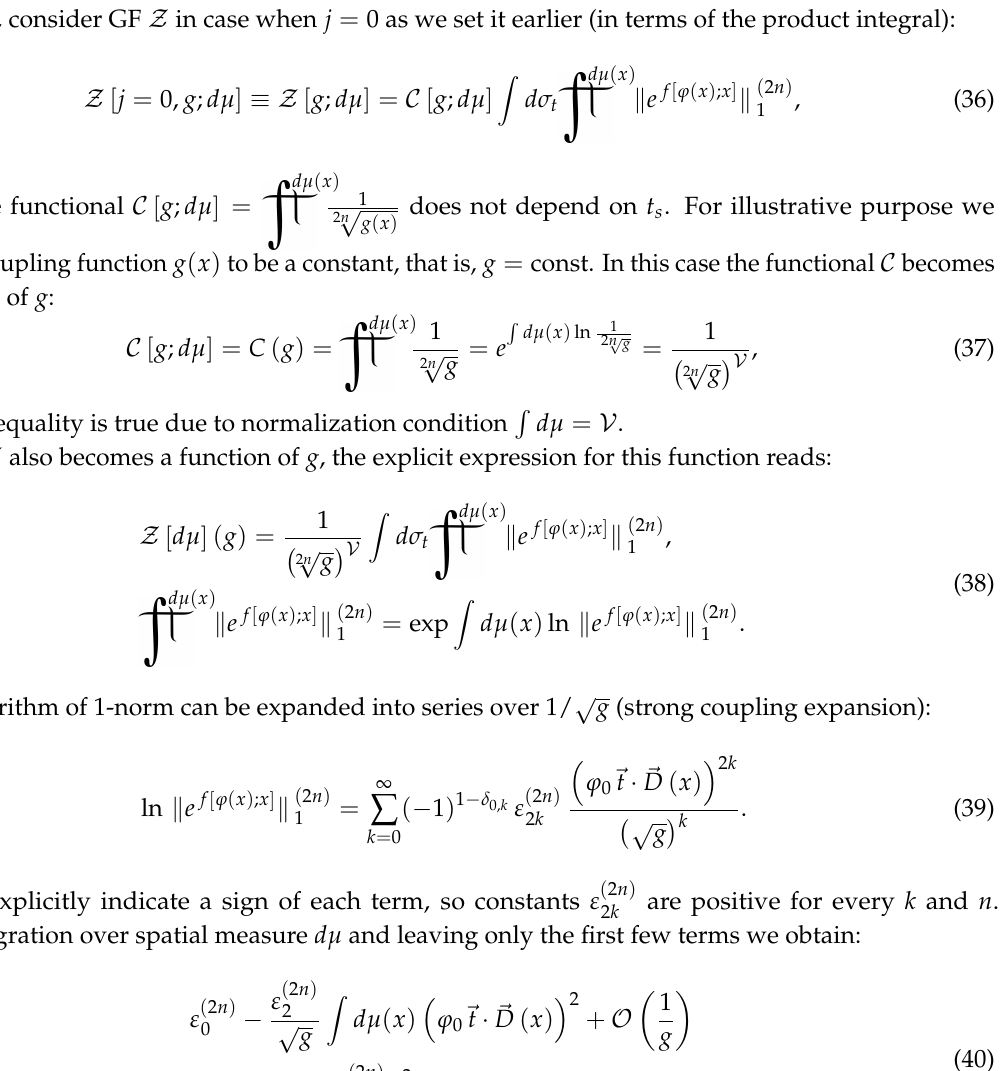
Figure 1. A plot demonstrates how the function value w . The plotted function is not